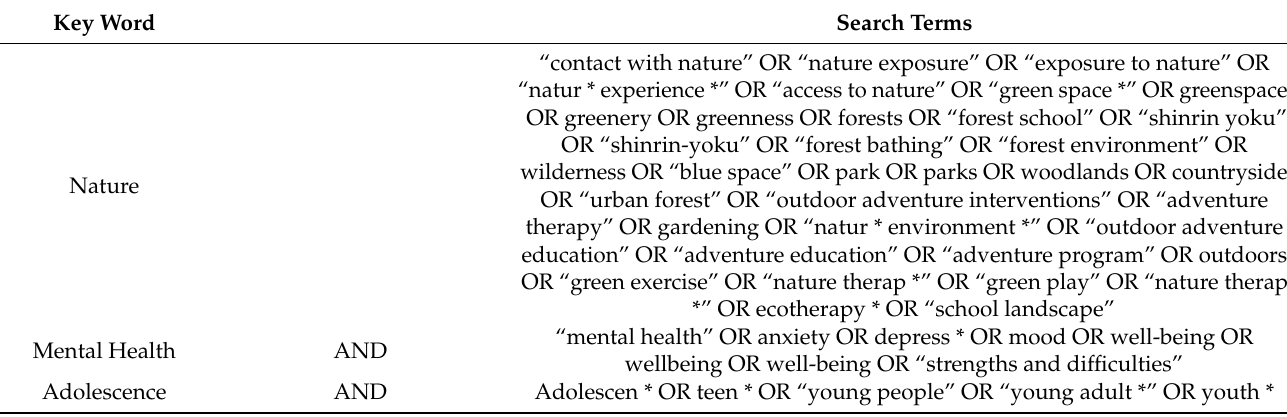
Table 1. Search Terms with Boolean